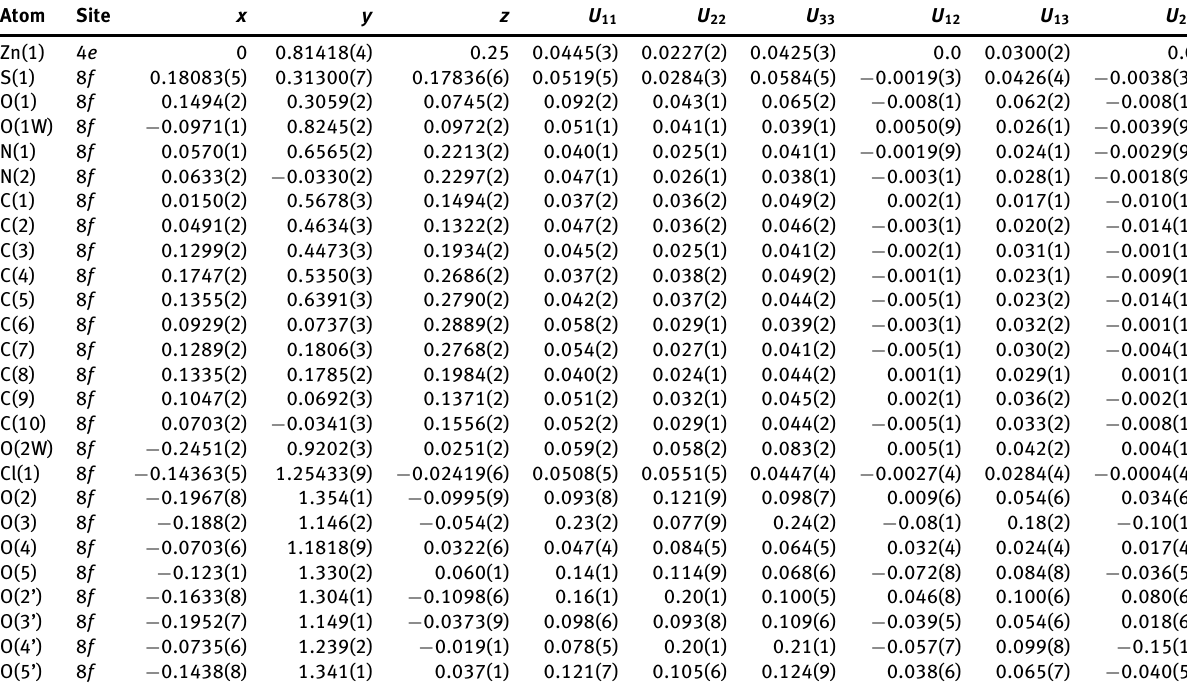
Table 3: Fractional coordinates and atomic displacement parameters (Å 2